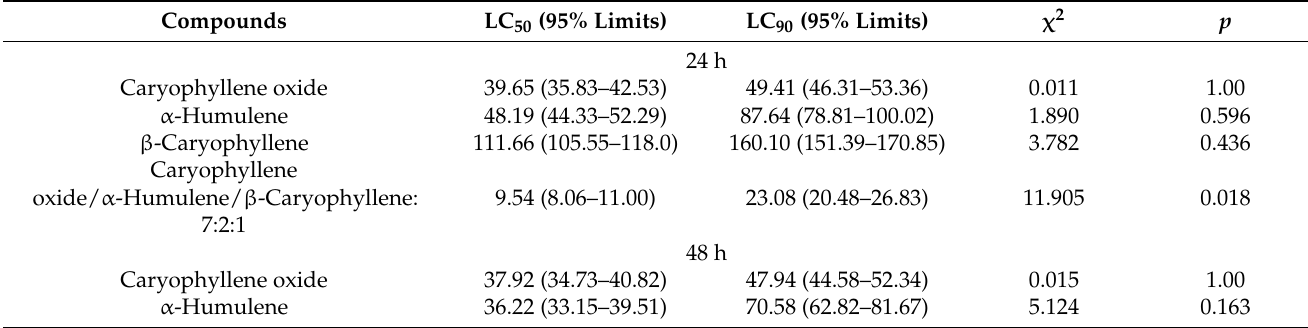
Table 2. Larvicidal activity of major compounds against Aedes aegypti ( µ